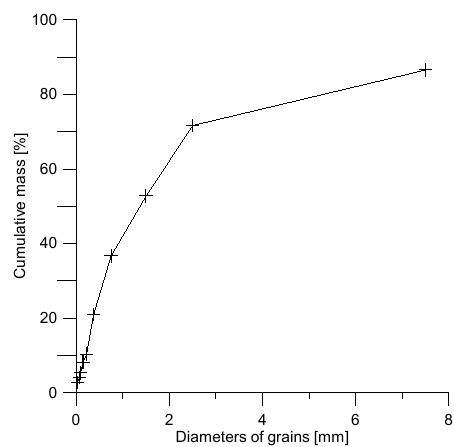
Figure 9. The grain size distribution of the post-outburst masses—Budryk coal mine.